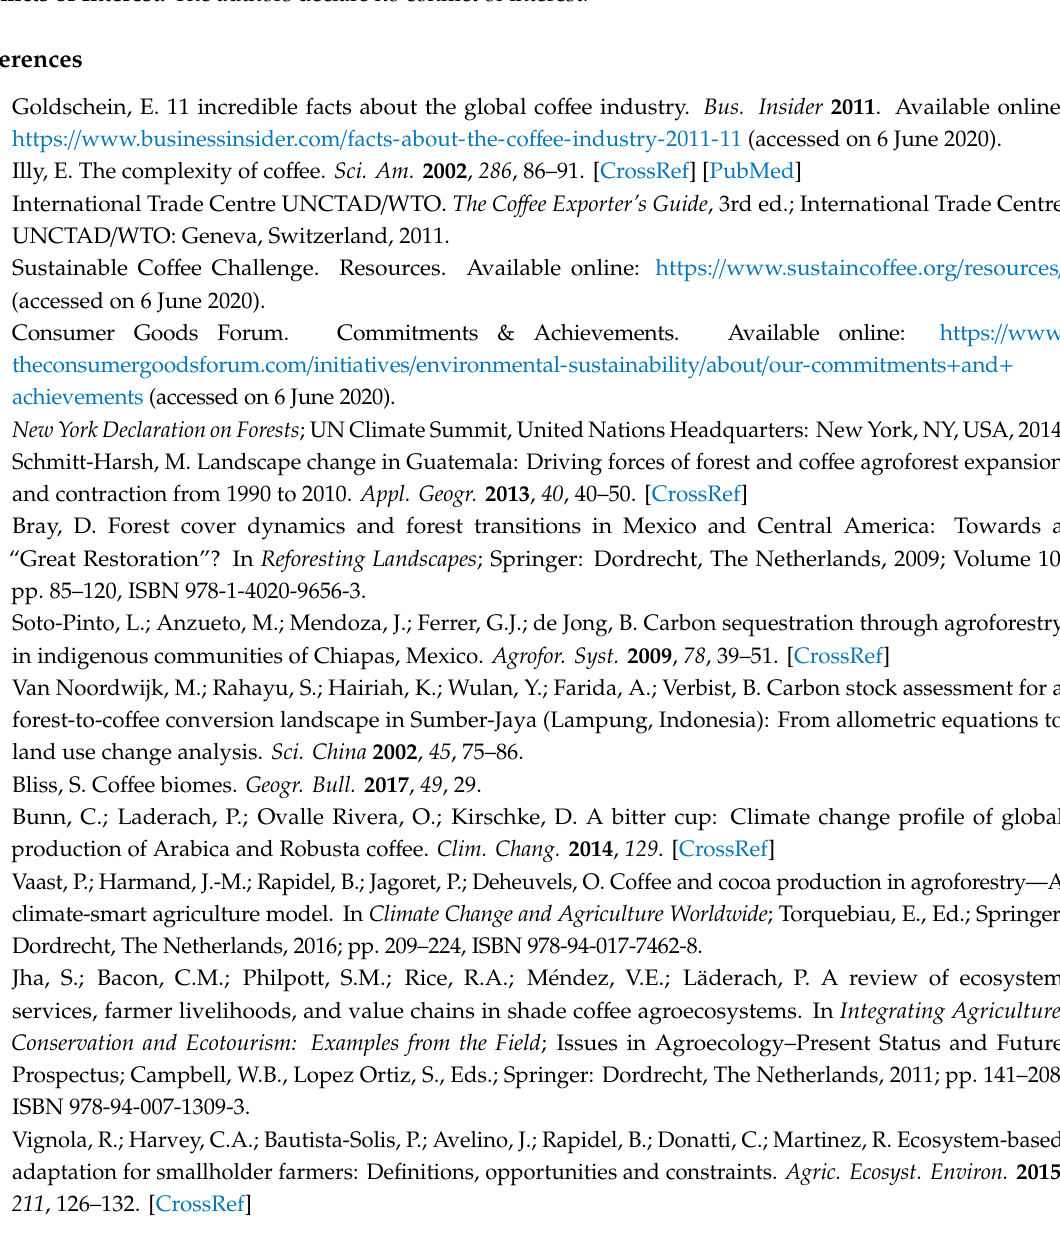
Table S1: Classification Methods from the Literature, Table S2: Considerations for Choosing the Best Method, Table S3: Validation Methods from the